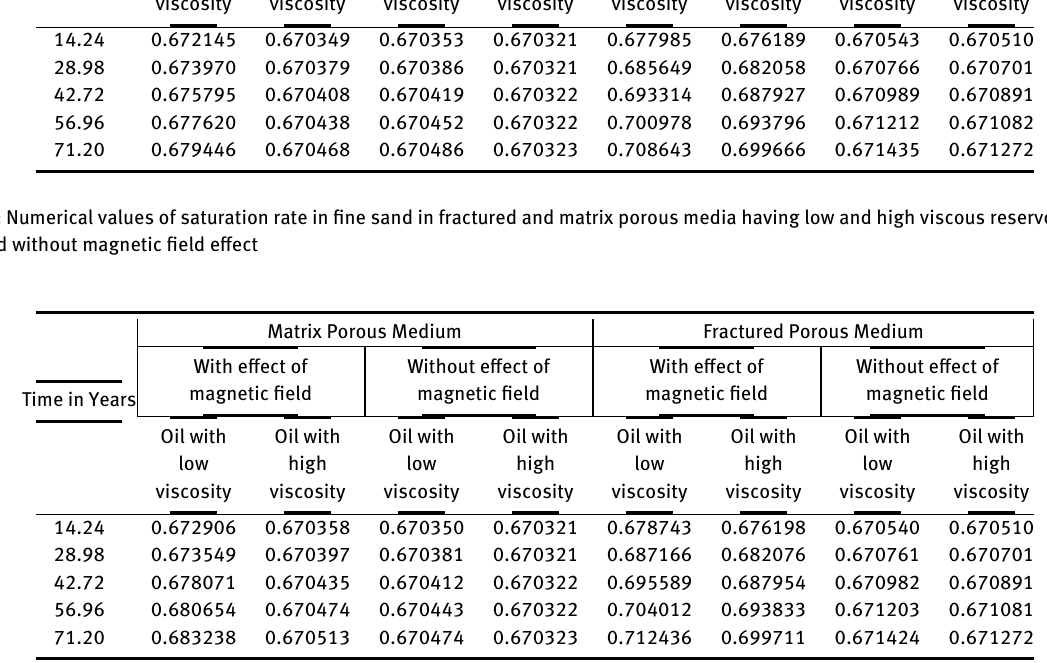
Table 3: Numerical values of saturation rate in glass beads in fractured and matrix porous media having low and high viscous reservoir fluids with and without magnetic field